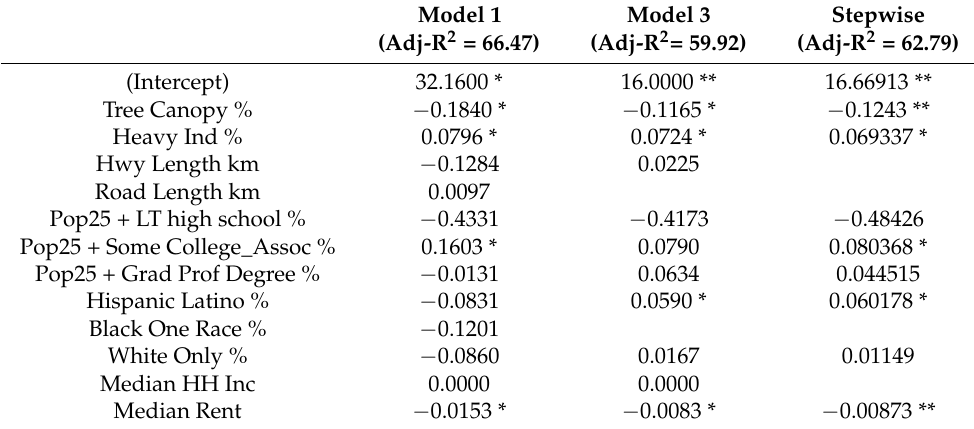
Table 8. Stepwise regression output.